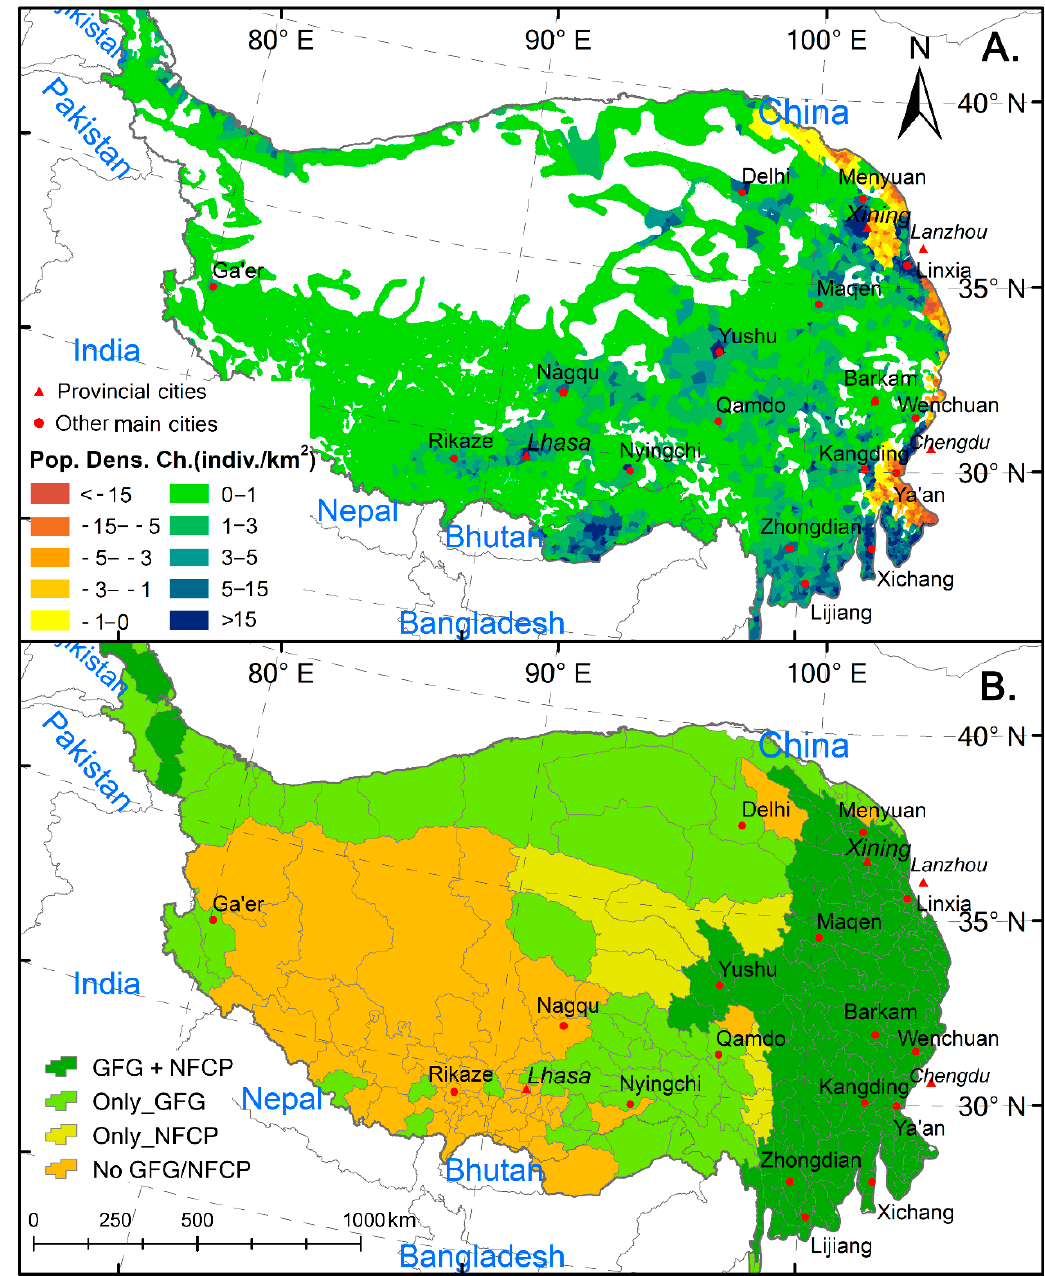
Figure A3. ( A ) Population density change (i.e., Pop. Dens. Ch. (indiv. / km 2 ) means the population density change at the unit of individuals per square kilometer) between 2000 and 2015, derived from population density data acquired from the Gridded Population of the World, Version 4 (GPWv4) collection; ( B ) two main ecological restoration programs in QTP (GFG, Grain for Green Program, NFCP, Natural Forest Conservation Program).